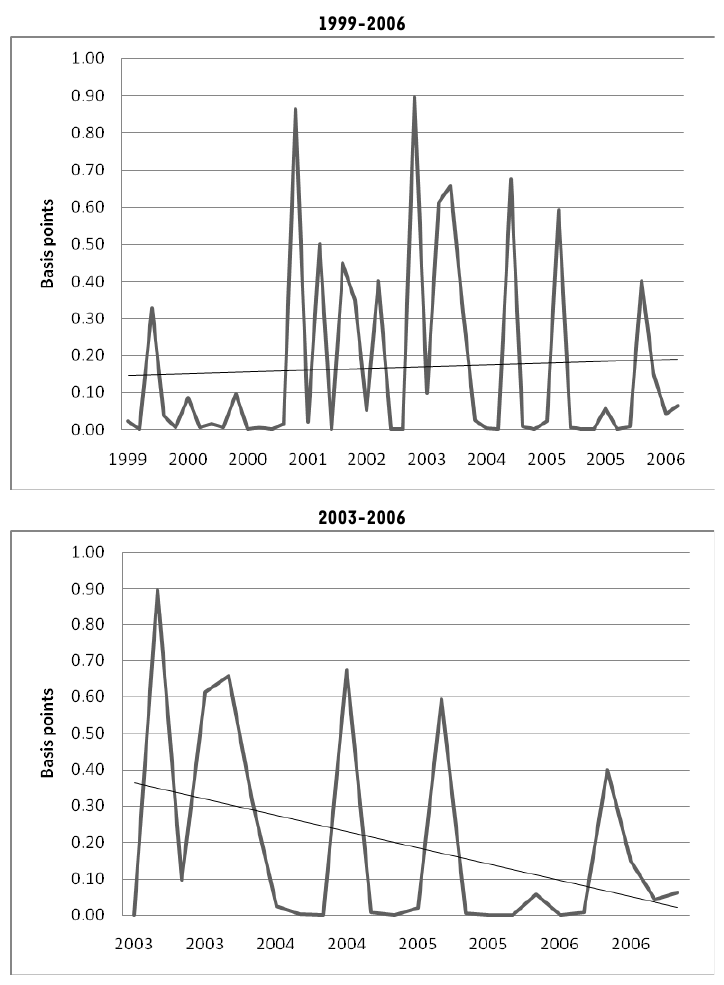
FIGURE 4: Fluctuations in the JIBAR Rate around MPC Announcement Dates, 1999-2006 (absolute value, in basis points, based on daily data) FIGURE 4a: 3-month JIBAR